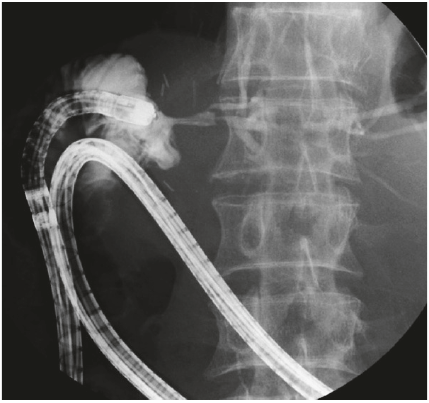
Figure 3: Contrast agent was stagnant around the anastomosis. MS can reduce recurrences of cholangitis and achieve long- term